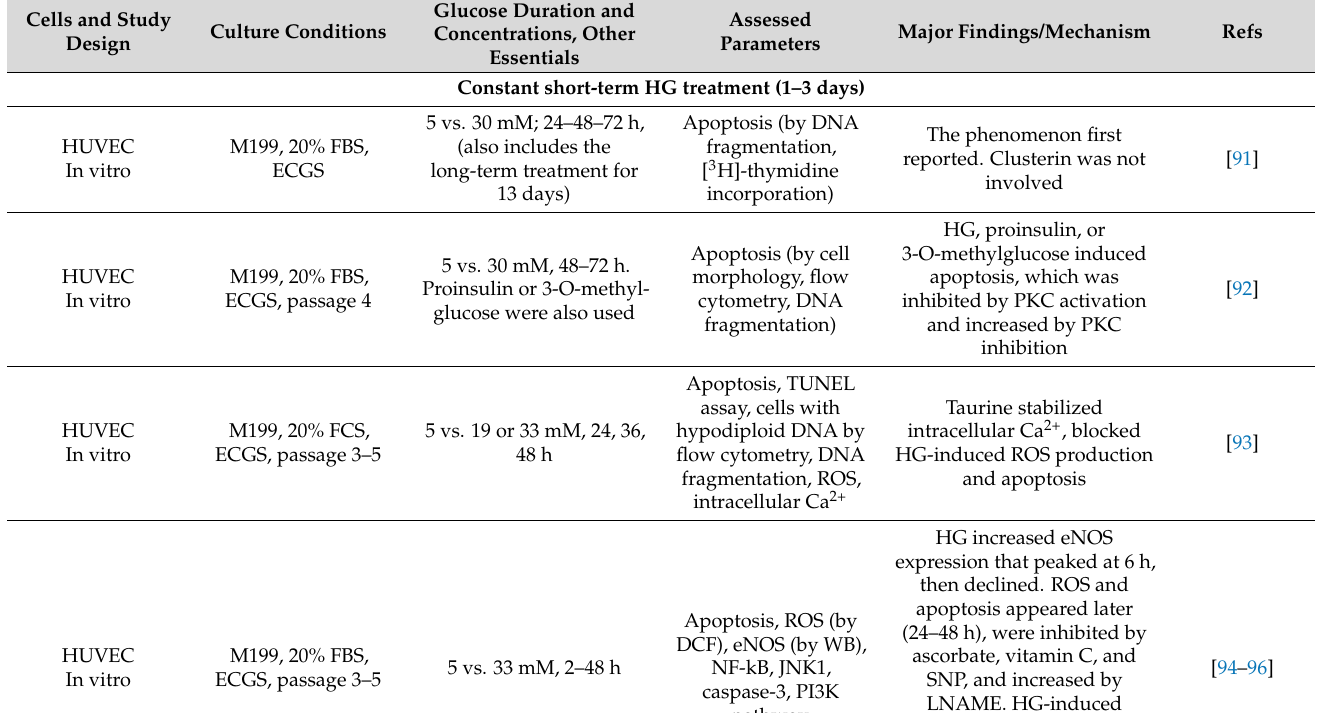
Table A1. Summary of the outcomes of high glucose effects on endothelial cells